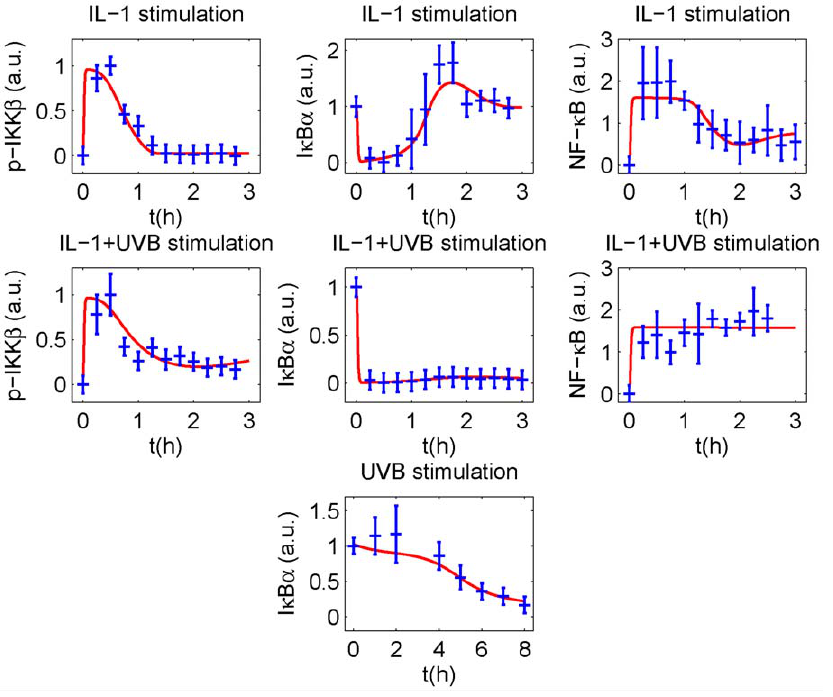
Figure 2. Model results in the reference model. Assuming both UVB induced PP2Ac deactivation and translational inhibition, the model convincingly reproduces the experimental data for IL-1 (10 ng/ml), IL-1 (10 ng/ml) + UVB (300 J/m 2 ) and UVB (300 J/m 2 ) stimulation. Experimental data and standard deviations (blue) of phosphorylated IKK b , total cellular I k B a and nuclear NF- k B are compared to the results of the model (red) fitted to these data. The NF- k B time courses were scaled to a mean of 1 and subsequently averaged. I k B a Western blots were standardised to an initial value of 1.